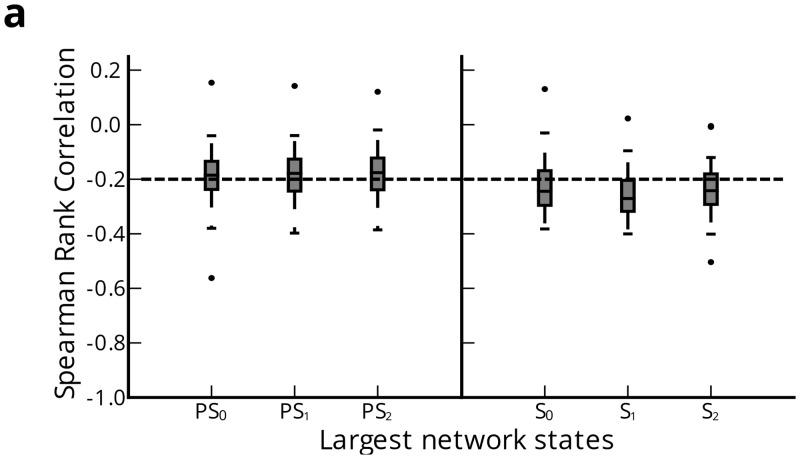
Topographical characteristics of network connectivity.(a) Average Spearman’s rank correlation coefficient between connection length and strength in PS and S epochs (N = 75). Physical connection lengths computed from regularly spaced nodes in electrode grid; connection lengths measured in millimeters. Stronger connections are consistently shorter than weaker connections. During S, there is significant topographical reorganization making weak connections longer and strong connections tighter.